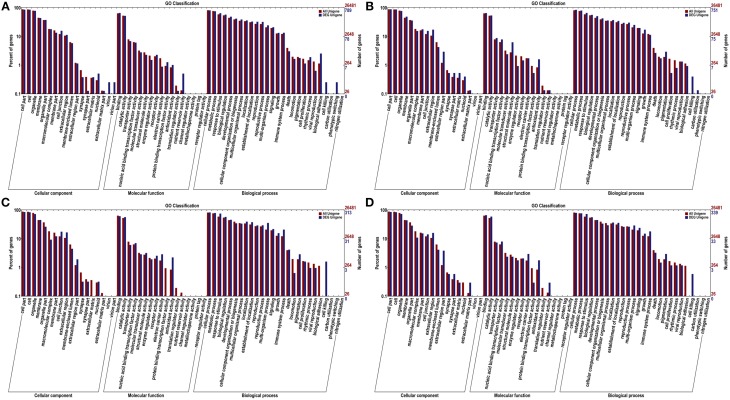
GO categories of unigenes and DEGs at 12 hpi (A), 24 hpi (B), 48 hpi (C), and 72 hpi (D). The genes were functionally categorized into three groups; “cellular component,” “molecular function” and “biological process.” Here, two levels of the assignment results were plotted. Gene number percentages are on ordinate left, the number of genes are on the right.